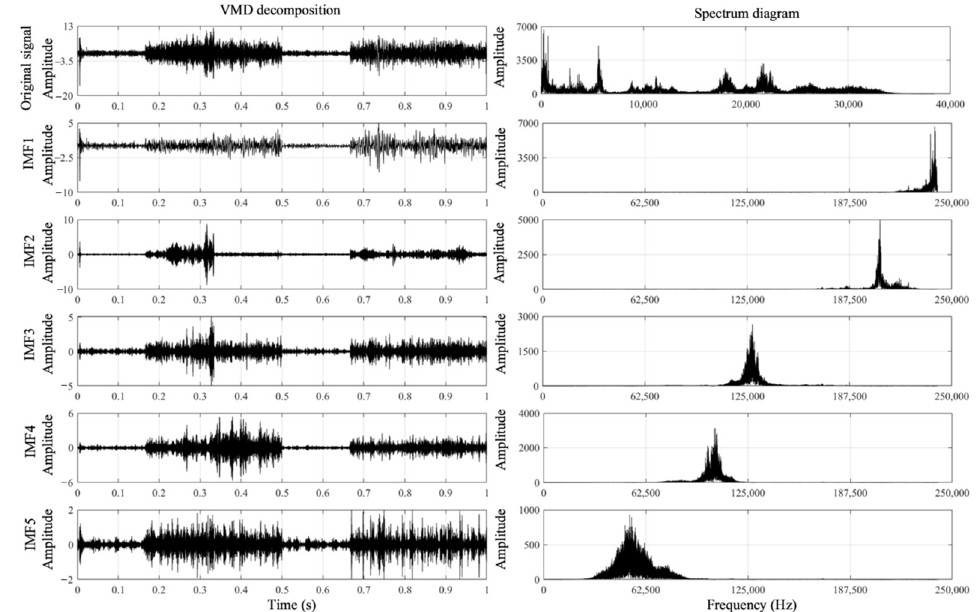
Figure 7. The vibration signal example after VMD decomposition in a channel. Table 7. The performance of different measurement channels under different defects.